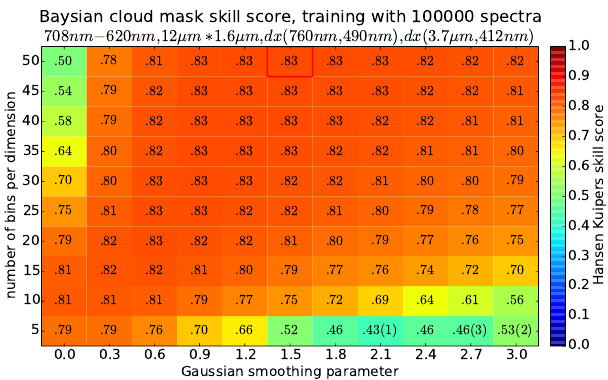
Figure 9. Similar to Fig. 8 but the sample size of the artificial truth was 1000 times larger with 100k cases.